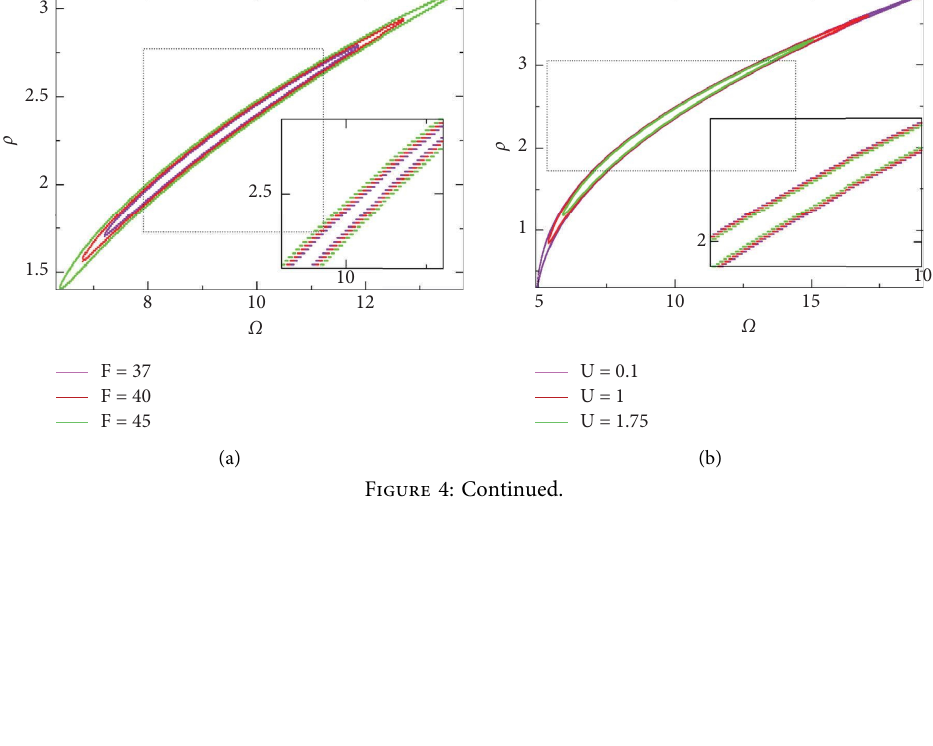
Figure 3: Frequency response curves for ϵ � 1 with the parameters: ω (a) Effect of amplitude F of external excitation, (b) effect of the control parameter U , and (c) effect of control gain parameter K